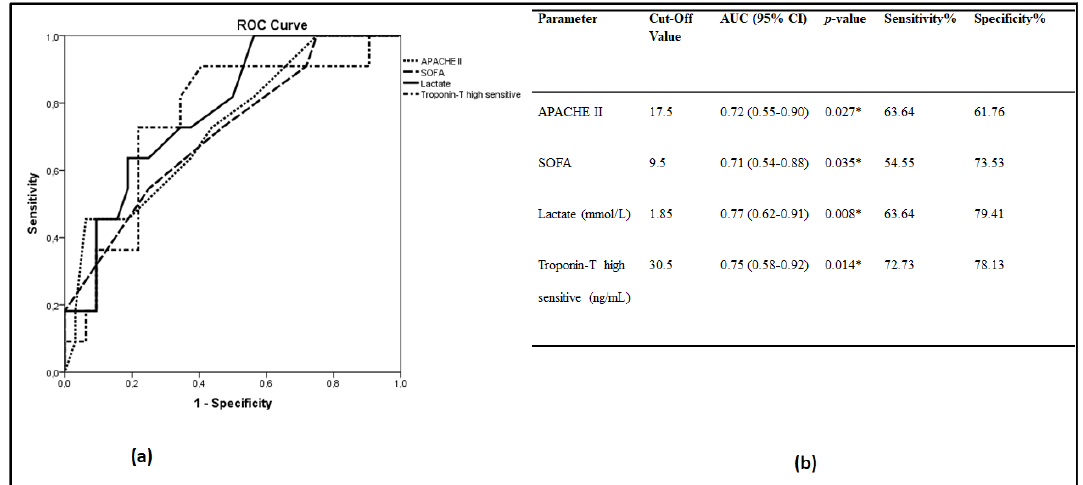
Figure 1. Lactate levels and 28-day mortality. ( a , b ) Receiver operating characteristic (ROC) curve analysis. ROC curves were generated to determine the prognostic accuracy of APACHE II, SOFA, high-sensitive troponin T and lactate, measured on ICU admission. ( a ) ROC curves; APACHE II, dotted line; SOFA, dashed line; high-sensitive troponin T, dash-dotted line; lactate, solid line; ( b ) The corresponding areas under the curve (AUC), 95% confidence intervals (CI) and the optimal cut-off values with the greatest combined sensitivity and specificity are given. * p -value < 0.05. Lactate measurements of days 1 and 2 were combined because admission to the ICU occurred mostly in late afternoon. APACHE = acute physiology and chronic health evaluation; SOFA = sequential organ failure assessment. Metabolites 2020 , 10 , x FOR PEER REVIEW